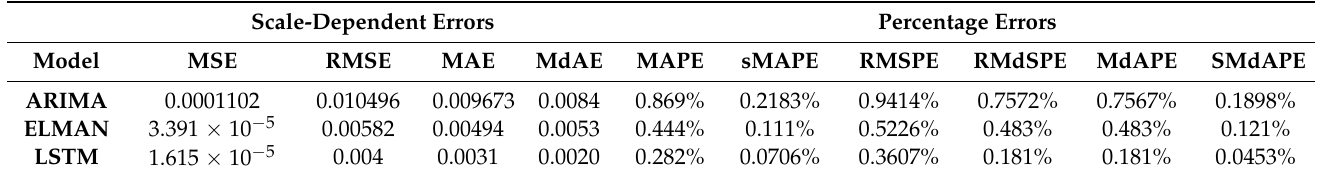
Table 1. Performance metrics for the three prediction models.